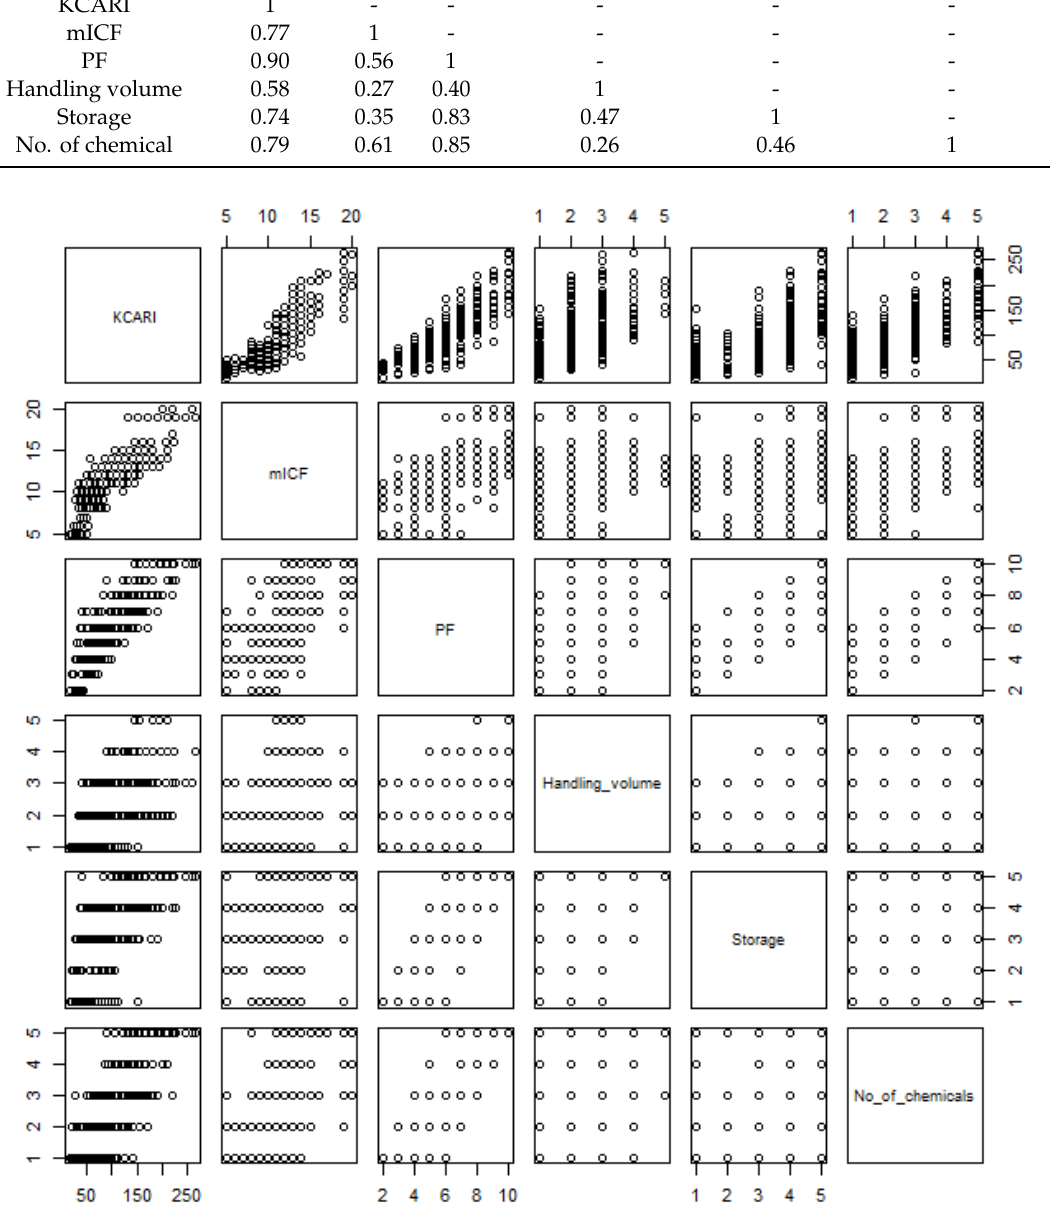
Figure 3. The scatter plot matrix of the index, factors, and PF sub-indices.